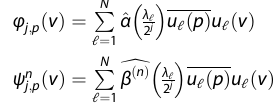
Table 1. All the features were linearly normalized to the range of [0, 1] prior to training the GNN models.